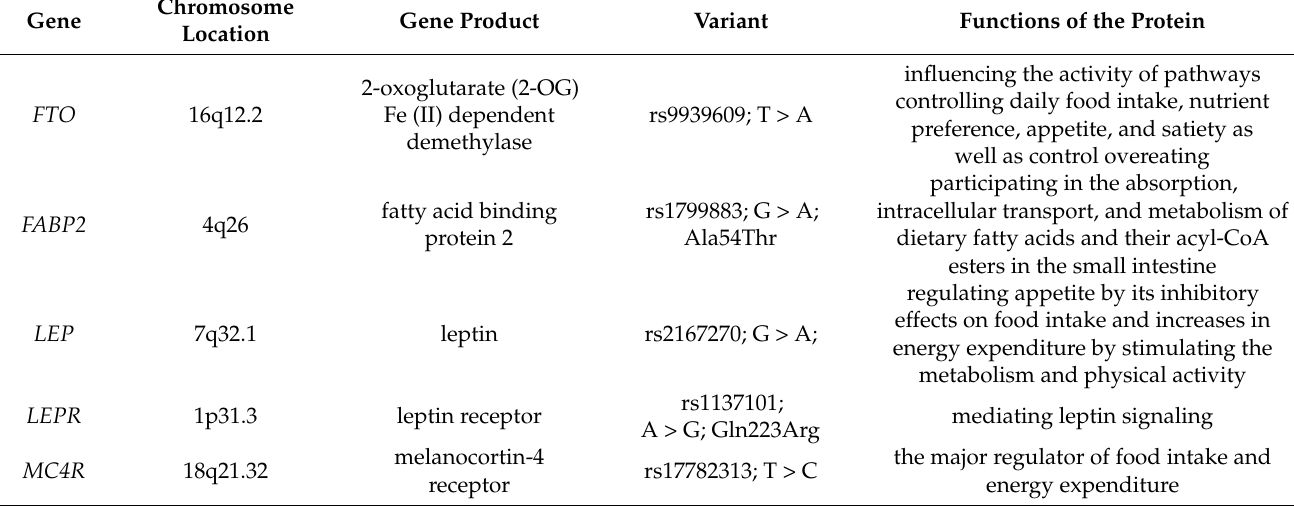
Table 1. Characteristics of the studied genes and polymorphic